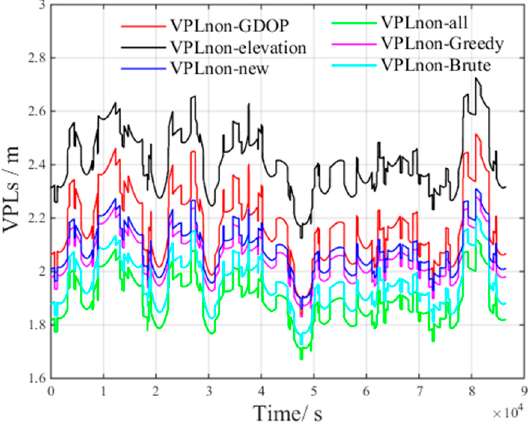
VPL of the new method under non-nominal troposphere. Figure 23. Figure 23. VPL non of the new method under non-nominal troposphere. non Table 9. Average VPL non , VPL bias and VPL C for the optimal satellite subsets obtained by the new method.